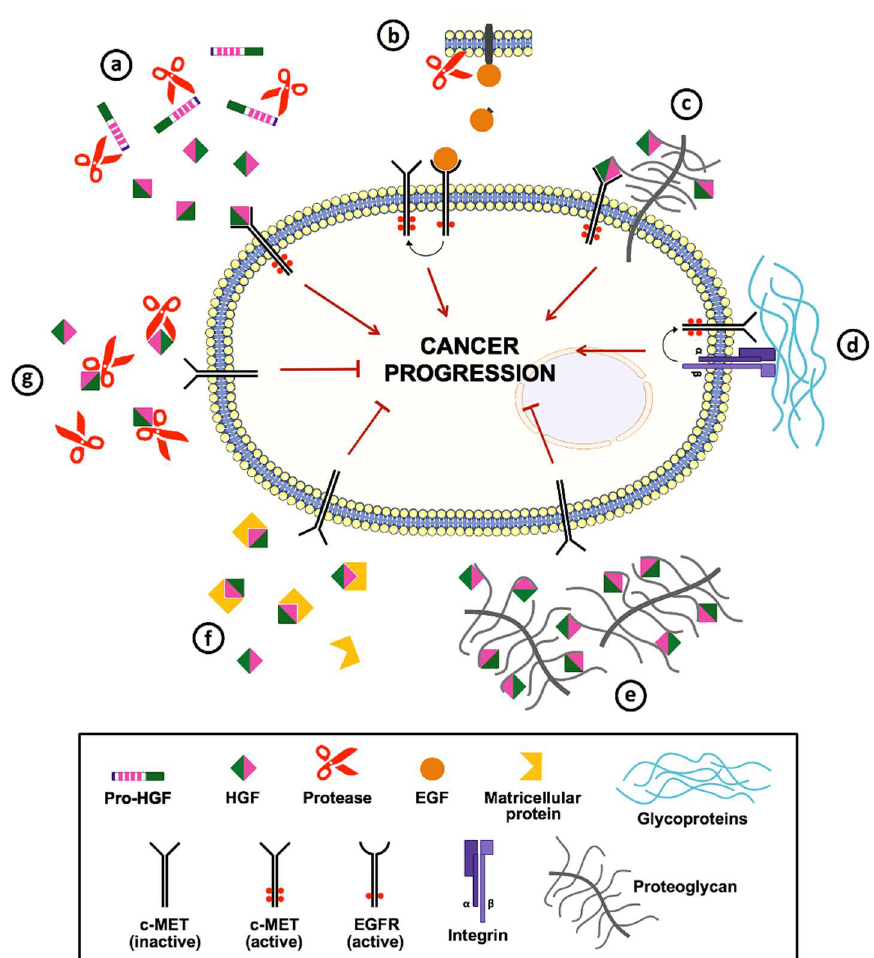
Figure 1. Schematic representation of the extracellular matrix (ECM) components implicated in the regulation of c-MET signaling. ( a ) Extracellular proteases (e.g., HGFA, matriptase and MMP-2) are able to cleave and convert pro-hepatocyte growth factor (HGF) (single-chain inactive precursor) into its biologically active form. ( b ) Besides, some proteases (e.g., MMP-1, ADAM-17 and ADAMTS-1) mediate the shedding of EGFR ligands from the cell membrane; the activated EGFR can interact with c-MET (crosstalk), resulting in the latter’s ligand-free activation. ( c ) Cell surface heparan sulfate proteoglycans (e.g., CD44 and syndecan-1) bind to HGF and act as co-receptors and presenters for c-MET. ( d ) Glycoproteins (e.g., laminin and fibronectin) promote the association of integrins with c-MET, leading not only to ligand-free activation of c-MET but also to amplification of signaling by both receptors. ( e ) In contrast, some proteoglycans (e.g., heparin) can directly bind to HGF and prevent its interaction with c-MET. ( f ) Matricellular proteins (e.g., TSP-1) are another ECM components capable of sequestering HGF. ( g ) Also, specific proteases (e.g., ADAMTS-1) can sequester or degrade HGF, preventing the activation of HGF/c-MET signaling pathway.